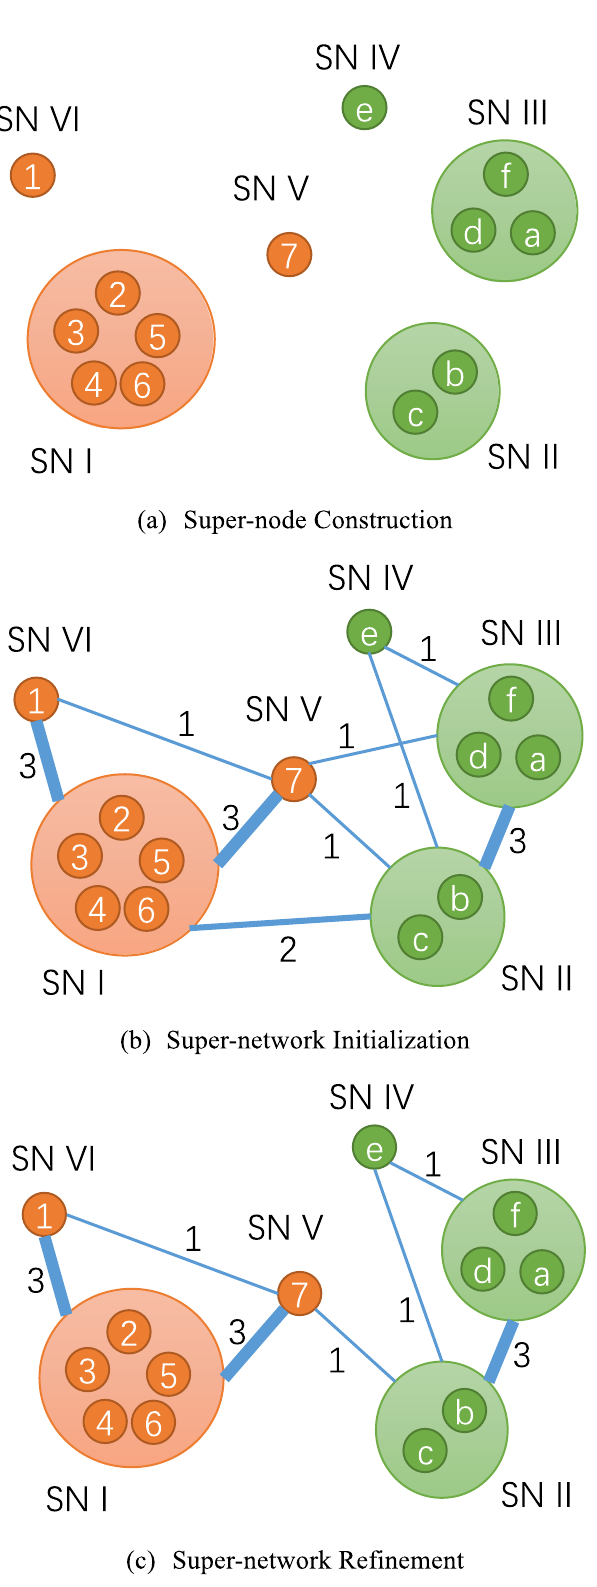
Figure 2. The overall process of the super-network